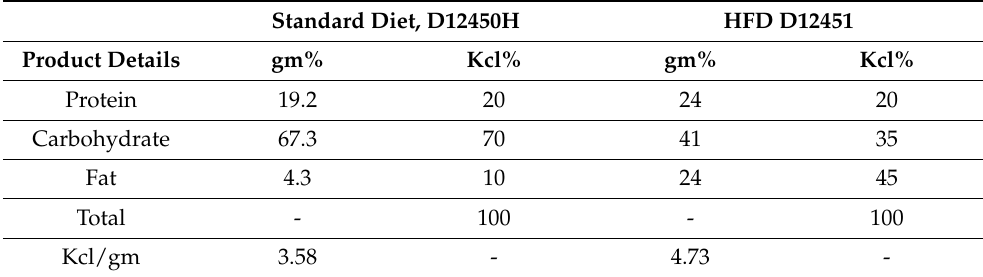
Table 1. Standard diet and high-fat diet (HFD)